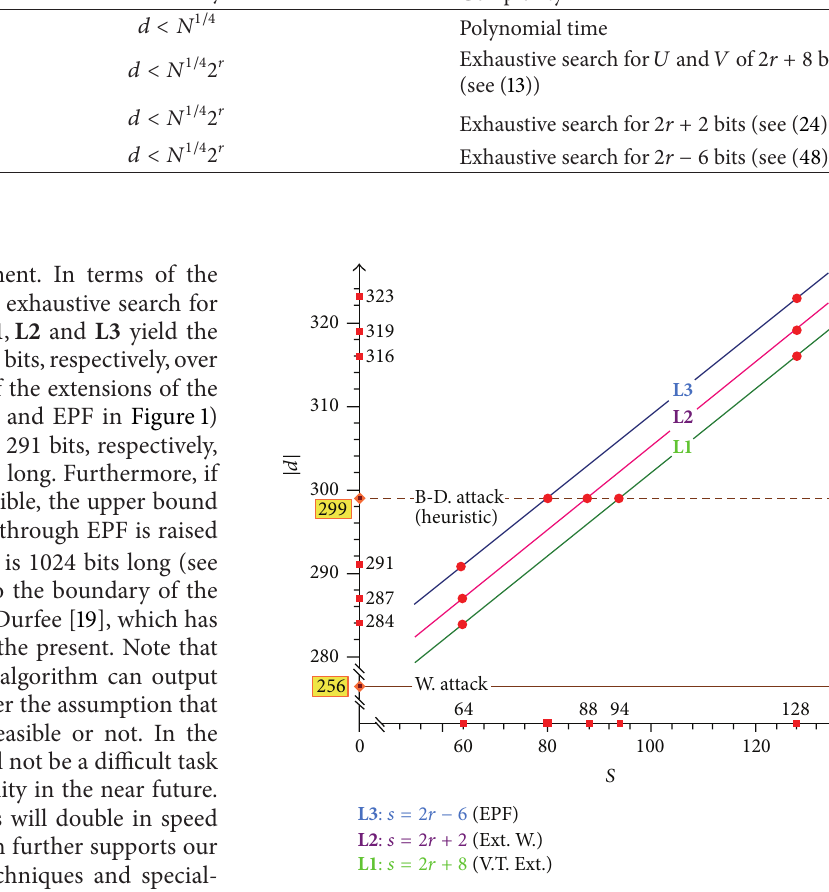
Figure 1: The boundaries of the extensions of the Wiener attack under different computational capabilities, where 256 and 299 are the boundaries of the Wiener attack (W. Attack) and Boneh and Durfee’s attack (B-D. Attack), respectively. L1 , L2 , and L3 denote the boundaries of Verheul and Tilborg’s extension (V-T. Ext . ) (see [20]), the extension of the Wiener attack (Step 1) (Ext. W.) (see (24)), and the extension of the Wiener attack through EPF (EPF) (see